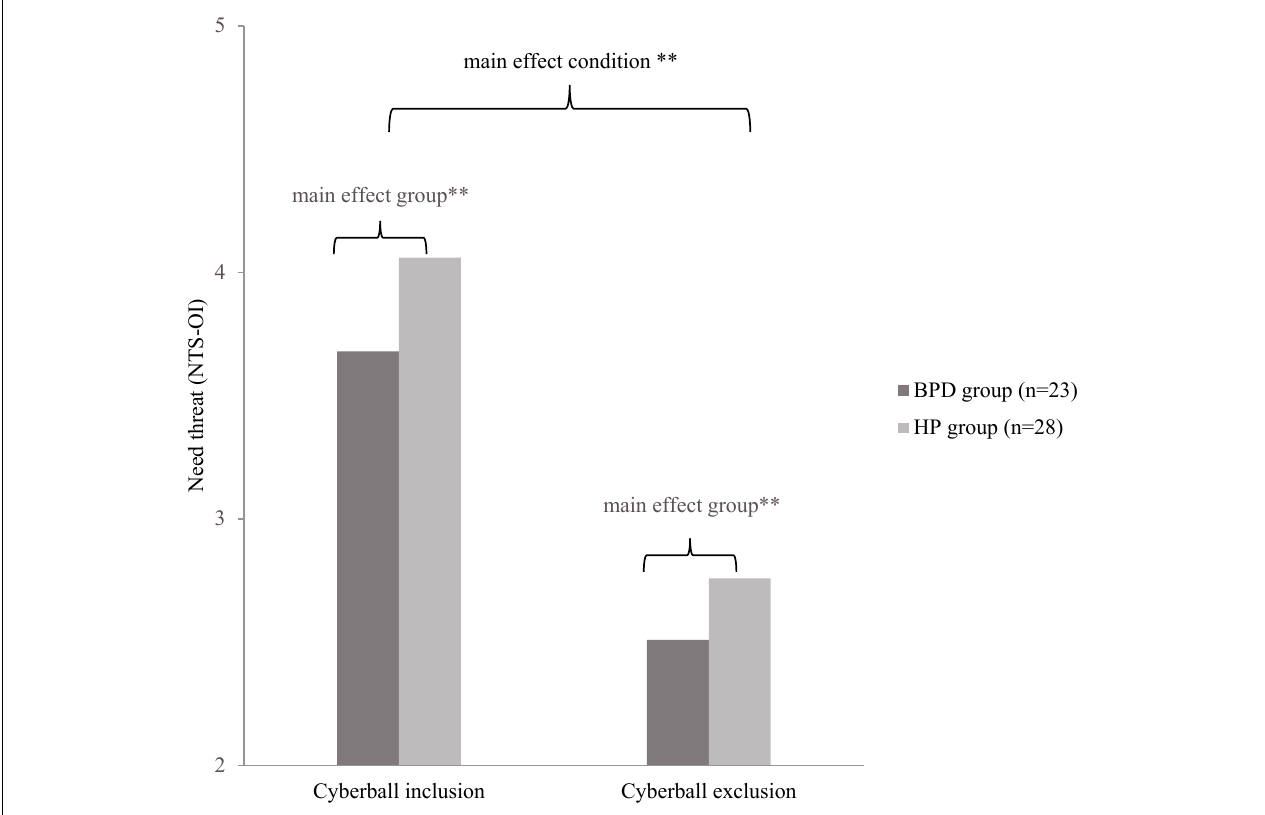
FIGURE 2 | NTS-OI = Need threat scale - overall mean index, BPD = Borderline Personality Disorders, HP = Healthy Participants. NTS-OI scores in Cyberball inclusion and exclusion condition for BPD and HP. A lower NTS-OI value indicates a higher need threat. ∗∗ p < 0.01.